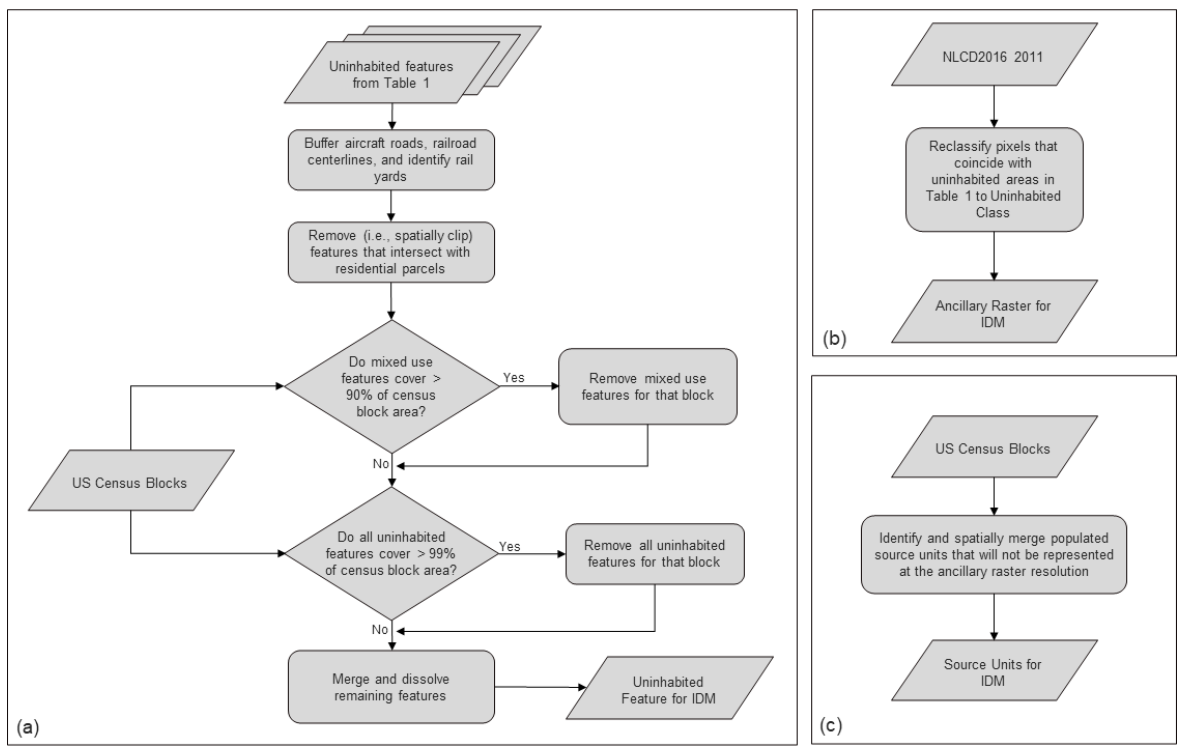
Figure 1. Data preparation workflow for uninhabited features (a) , ancillary raster (b) , and source units (c) for IDM